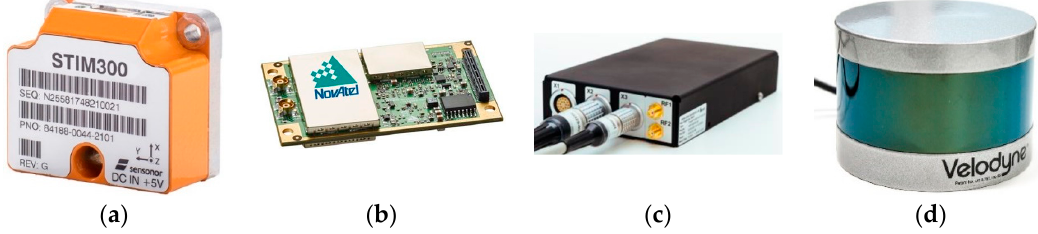
Figure 1. Sensors: ( a ) STIM 300 (© Sensonor AS, Horten, Norway); ( b ) Novatel OEM7720 GNSS dual receiver (© Novatel Inc., Calgary AB, Canada); ( c ) iMAR-M200-FLAT INS; ( d ) Velodyne LiDAR PUCK. GNSS Antenna